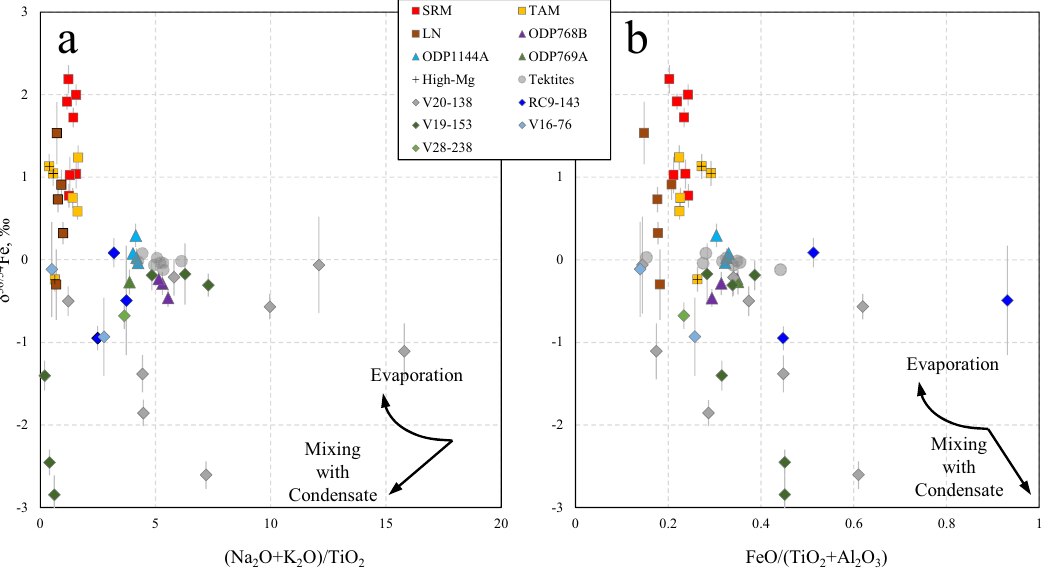
Fig. 7 Fe isotopic signatures vs bulk compositions. a – Plot of δ 56/54 Fe versus the alkali elements normalized by the refractory element Ti to illustrate the effect of evaporation and condensation on volatile elements in microtektites. The Australasian microtektites that experienced the hottest conditions in the impact plume display the lowest concentrations in the alkali elements, together with the highest magnitudes of Fe isotope fractionation, both in positive and negative direction. The Antarctic microtektites experienced additional evaporation during atmospheric re-entry. b – Diagram of δ 56/54 Fe versus FeO normalized to major refractory elements, used to demonstrate that the absolute FeO concentrations are affected by volatile loss of Fe rather than the volatilization of other, more volatile major elements. SRM Sør Rondane Mountains, Antarctica, TAM Transantarctic Mountains, Antarctica, LN Larkman Nunatak,